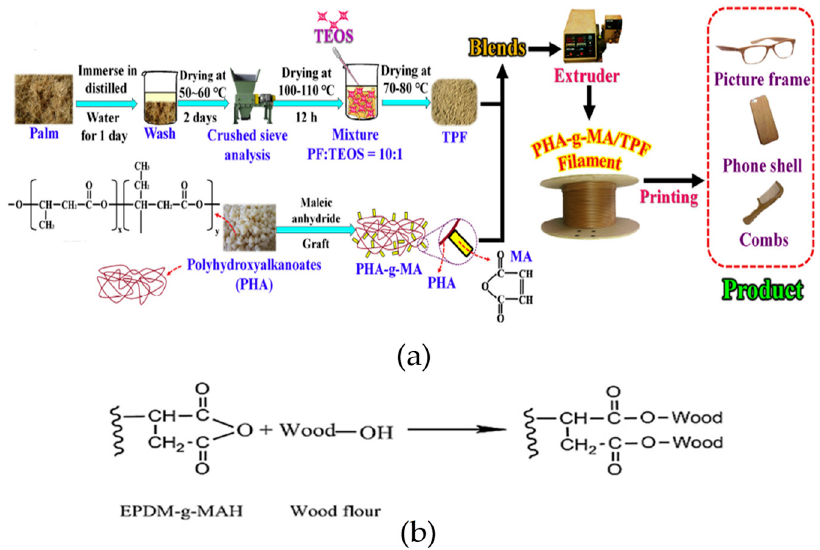
Figure 15. Two methodologies to develop natural fiber reinforced FFF materials: ( a ) in-laboratory prepared graft polymer for chemical processed natural palm fibers, adapted from [4], with permission from © 2017 Elsevier; and ( b ) modification of fibers matrix (TPU / WF) with modifier (EPDM-g-MAH) adapted from [164], with permission from © 2018 Elsevier .